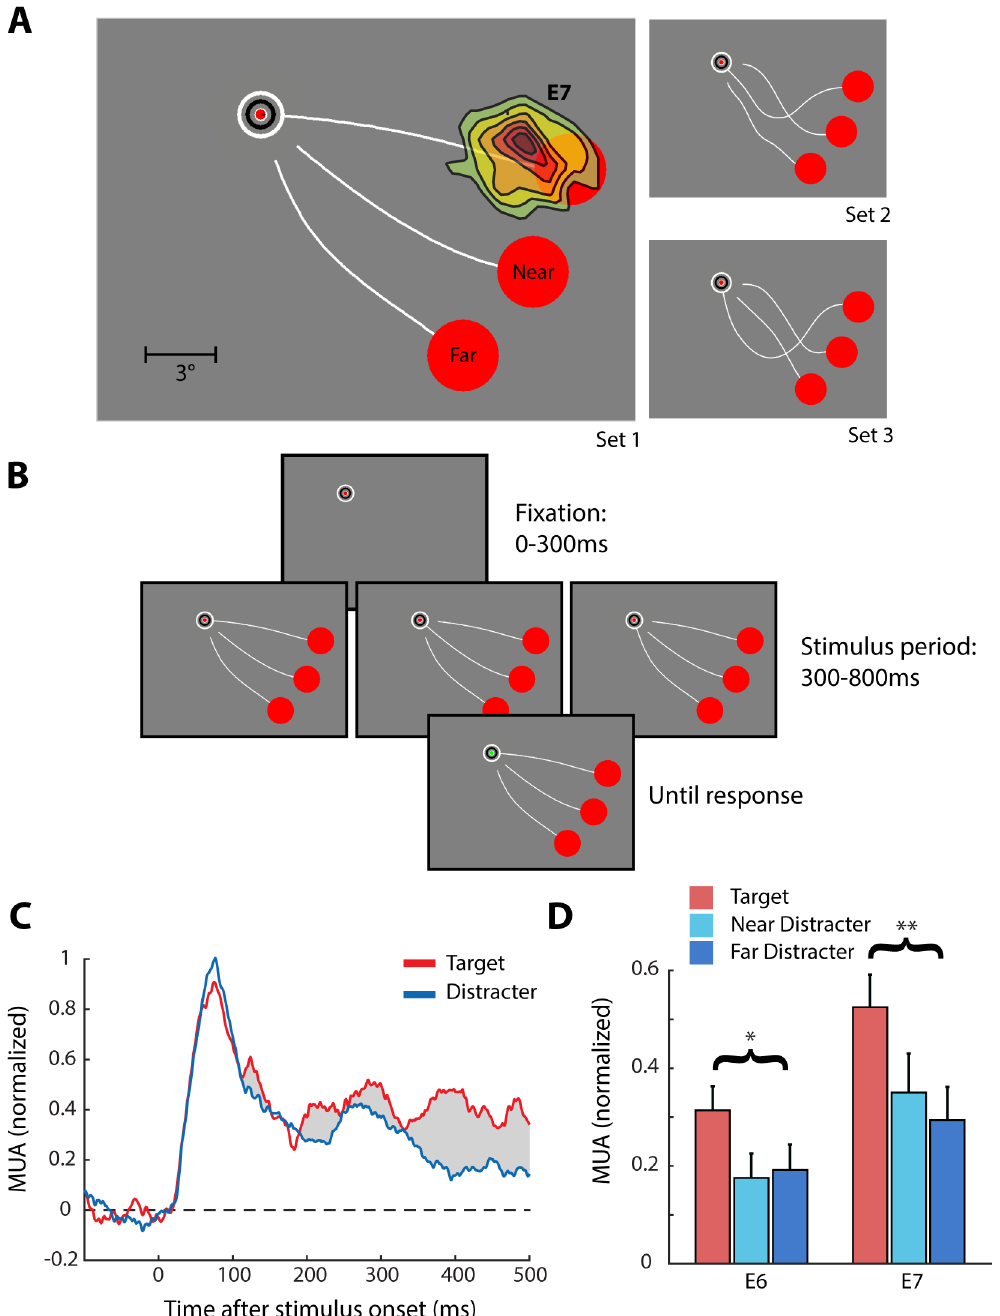
Fig 7. Attentional modulation of spiking activity in human V2/V3. (A) Example stimulus of the curve-tracing experiment. The RF of MUA at E7 is also shown. There were two distractor curves, which were connected to two other circles near and far from the RF. The right panels illustrate the two alternative stimulus configurations. (B) The stimulus paradigm: The patient initially had to fixate for 300 ms. One of nine possible stimulus configurations was shown, the three curve configurations of stimulus set 1 are shown here. The patient had to mentally trace the target curve attached to the fixation point. After a delay of 500 ms the fixation point turned green and the patient was required to make a saccade towards the red target circle connected to the fixation dot. (C) The MUA response averaged across E6 and E7 when the RFs fell on the target curve (red line) or on one of the two distractor curves (blue line, averaged across near and far distractor). The attentional modulation is the difference between the two responses (gray shading). (D) The average response at E6 and E7 in a window from 200 to 500 ms elicited by the target curve (red bar) and the distractors (blue bars). The asterisks indicate the significance of the difference in MUA between the target and distractor conditions as assessed by a t test ( * = p < 0.05, ** = p < 0.01). Error-bars indicate 1 S.E.M. Data is available from